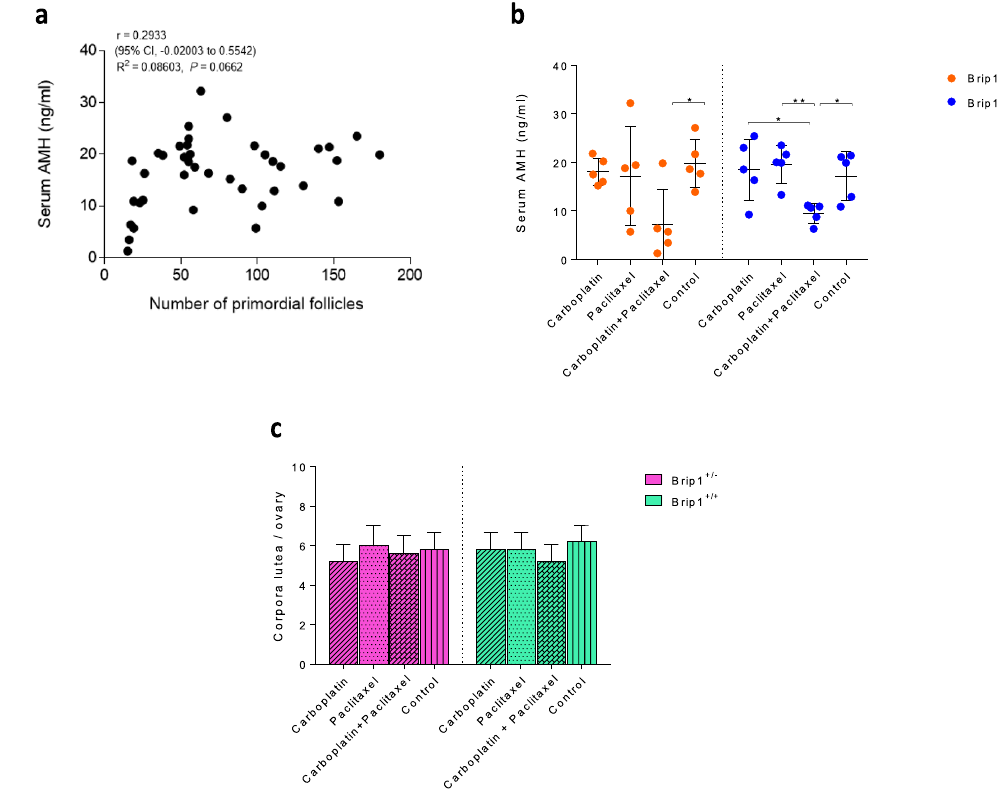
Figure 3. ( a ) Correlation between the AMH serum concentration and the number of primordial follicles in the ovary from all mice used in the study. The graph indicates a trend of the two variables to increase or decrease together. ( b ) AMH serum concentrations of treated Brip1 + /− and Brip1 + / + mice quantified by electrochemiluminescence immunoassay at the end of the treatment. ( c ) Total number of corpora lutea counted per ovary. Data are presented as mean ± SD; n = 5/treatment/genotype; *p < 0.05, **p <